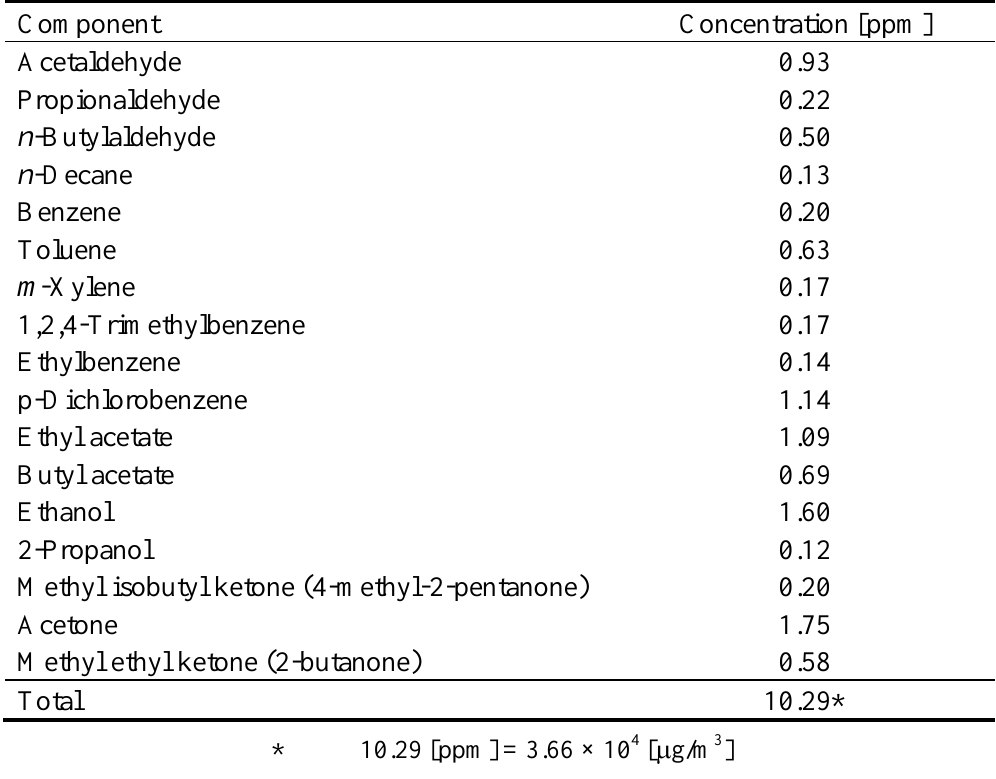
Table 1. Concentrations of each component in the T–VOC test gas